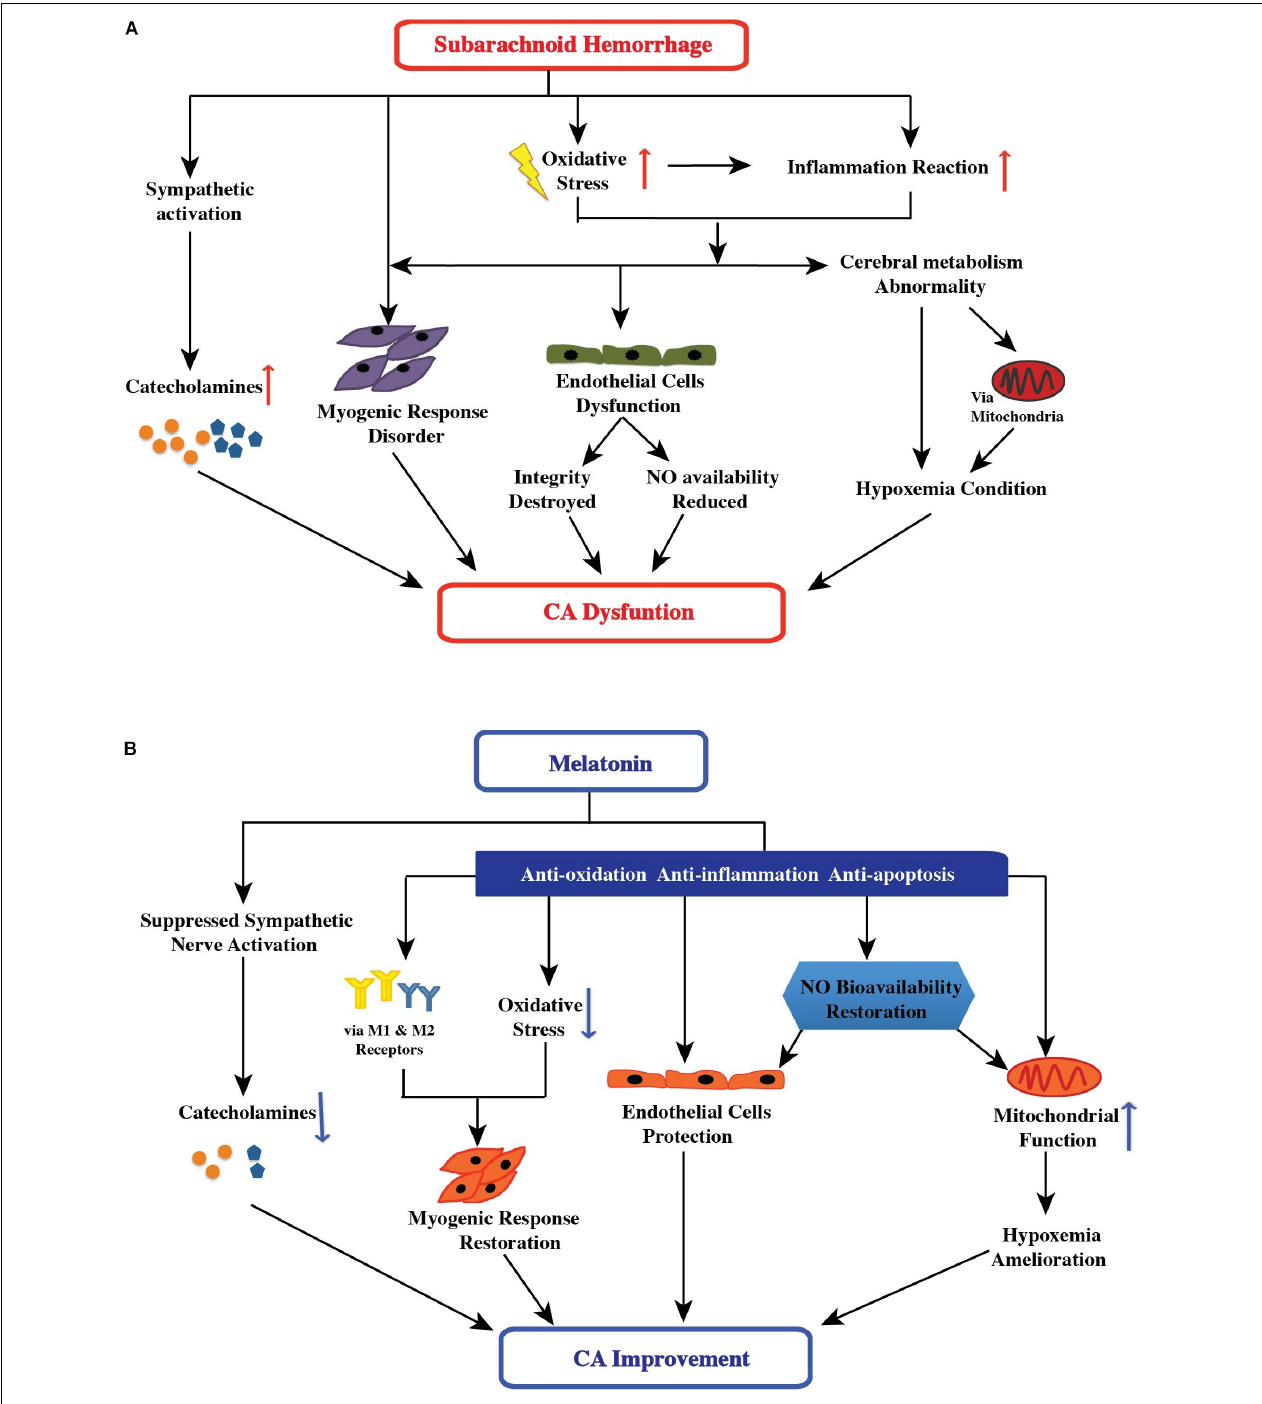
FIGURE 1 | (A) Effect of subarachnoid hemorrhage on the control mechanisms of cerebral autoregulation. After subarachnoid hemorrhage, oxidative stress is implicated in the etiology of all stages: the high free-radical concentration leading to impaired cerebral autoregulation has direct and indirect effects, including changing smooth muscle tone, damaging endothelial cell function (followed by destruction of endothelial cell integrity and reduction of nitric oxide availability), and inducing an inflammatory response (followed by endothelial cell dysfunction and hypoxemia). Additionally, sympathetic activation and abnormal cerebral metabolism after SAH aggravated the impairment of cerebral autoregulation. (B) Possible therapeutic targets of melatonin in improving cerebral autoregulation after subarachnoid hemorrhage. After subarachnoid hemorrhage, melatonin may potentially impact the control mechanisms of cerebral autoregulation via suppression of sympathetic nerve and antioxidant activity, increase in nitric oxide bioavailability, direct and indirect mediation of the myogenic response, and amelioration of hypoxemia. Furthermore, melatonin can have a comprehensive effect on cerebral autoregulation.